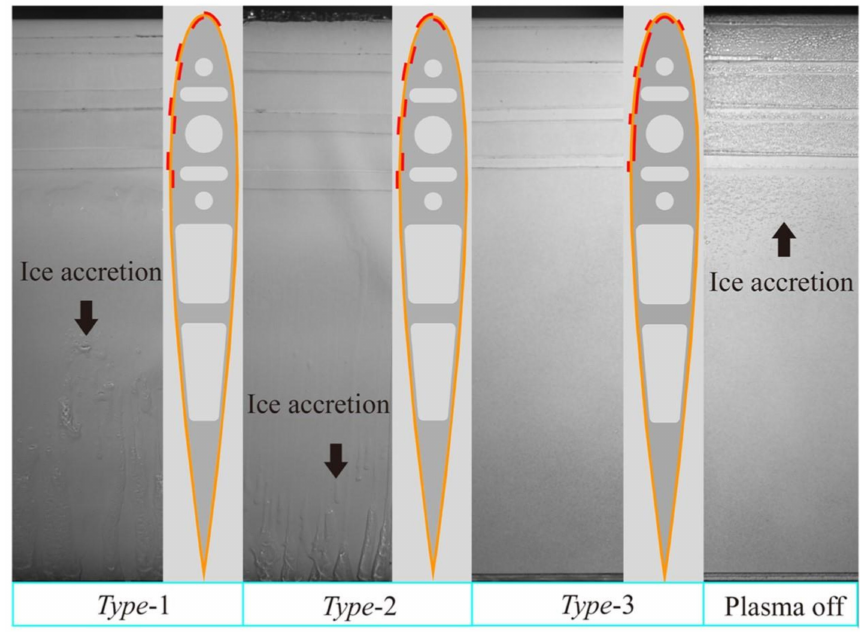
Figure 24. Ice accretion on the airfoil surface after 112 s (adapted from Meng et al. [187] with the permission of AIP